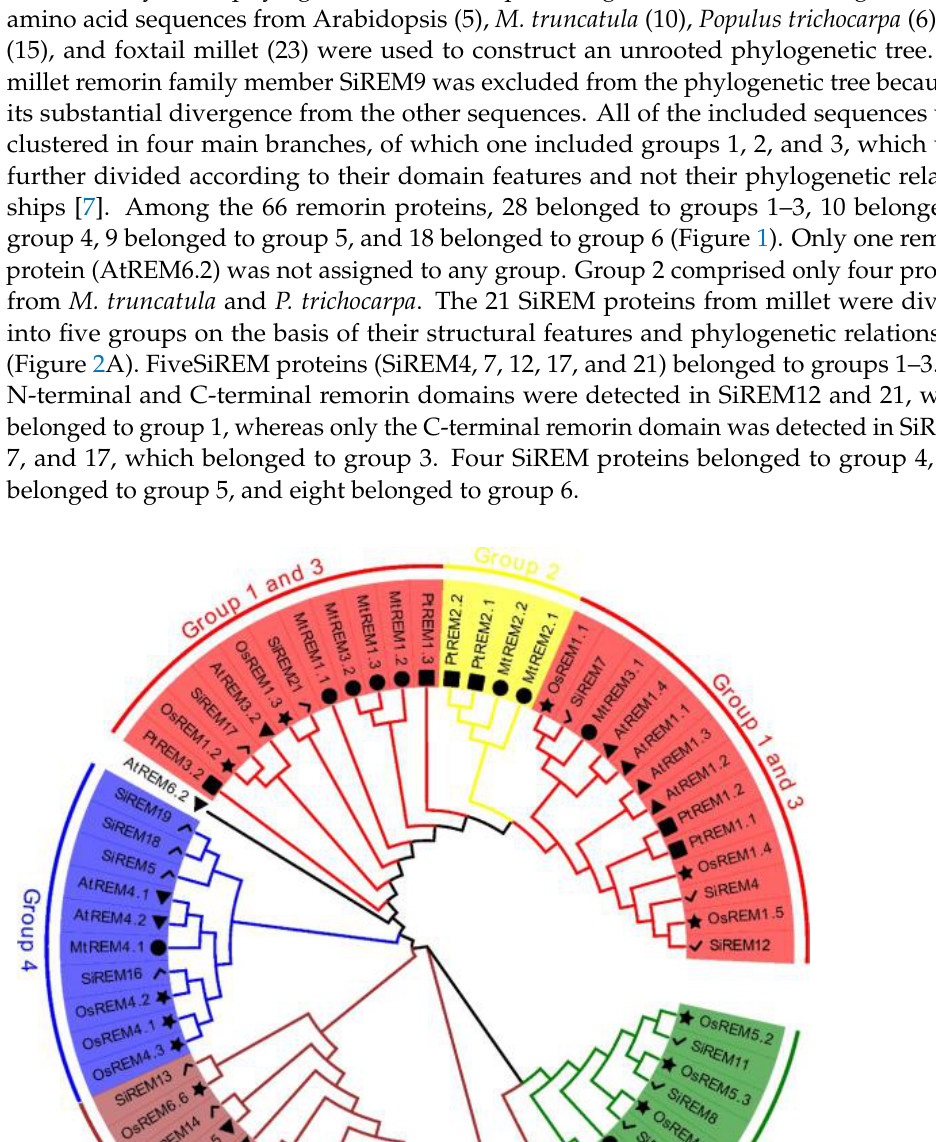
Figure 2. Phylogenetic relationships, gene structure, and conserved motifs of SiREM proteins. ( A ). Phylogenetic tree constructed based on the full-length sequences of millet remorin proteins using MEGA 7. ( B ). Exon – intron structure of millet remorin genes. Blue boxes indicate the 5′ and 3′ untranslated regions; yellow boxes represent exons; and black lines represent introns. ( C ). Motif composition of millet remorin proteins. The motifs, numbered 1 – 21, are indicated by different colored boxes. 3.3. SiREM Gene Structures and Encoded Motif Compositions To